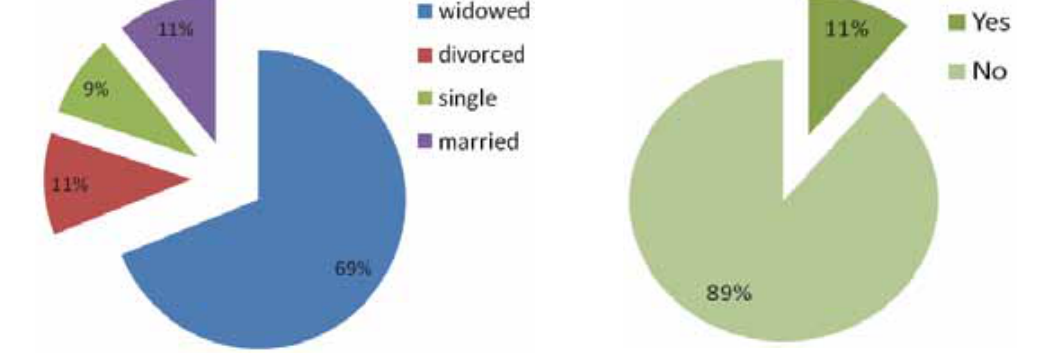
FIGURE 4. prevalence of diagnosed depression FIGURE 3. Marital status of